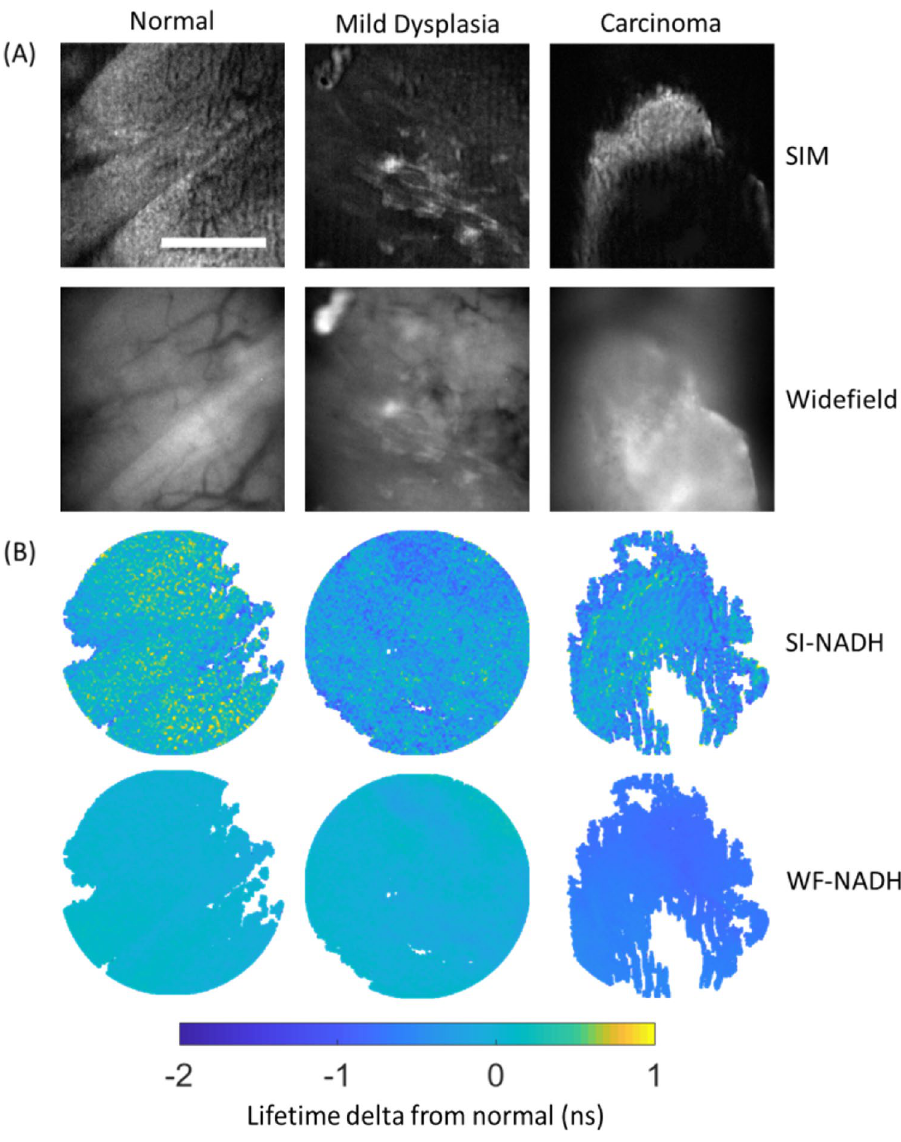
Figure 3. Example structured illumination and widefield image dataset of ( A ) fluorescence intensity and ( B ) fluorescence lifetime images for (left) normal, (center) mild dysplasia, and (right) carcinoma. Fluorescence lifetime scale is presented as delta change from the median lifetime obtained from paired contralateral normal images. Scale bar is 220 µm in